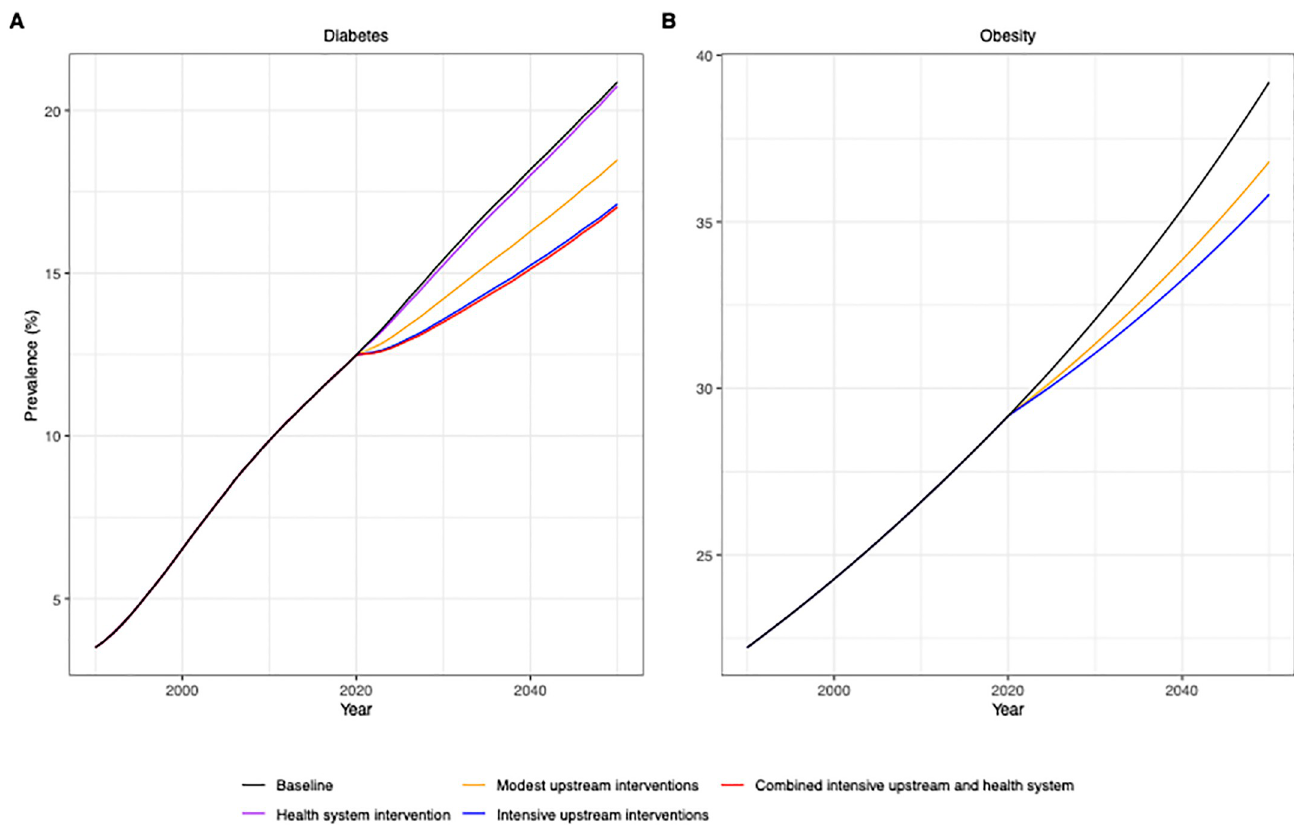
Fig 4. Effects of scenarios for intervention relevant to the Caribbean on diabetes (A) and obesity (B) prevalence in adults (20+ years).